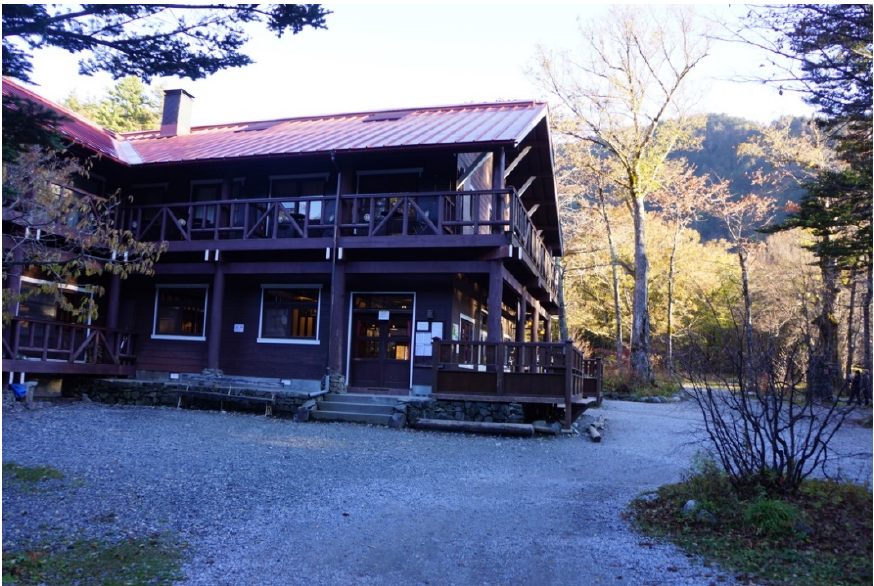
Figure 3. Tokusawa-en Mountain Hut. Photo by author.